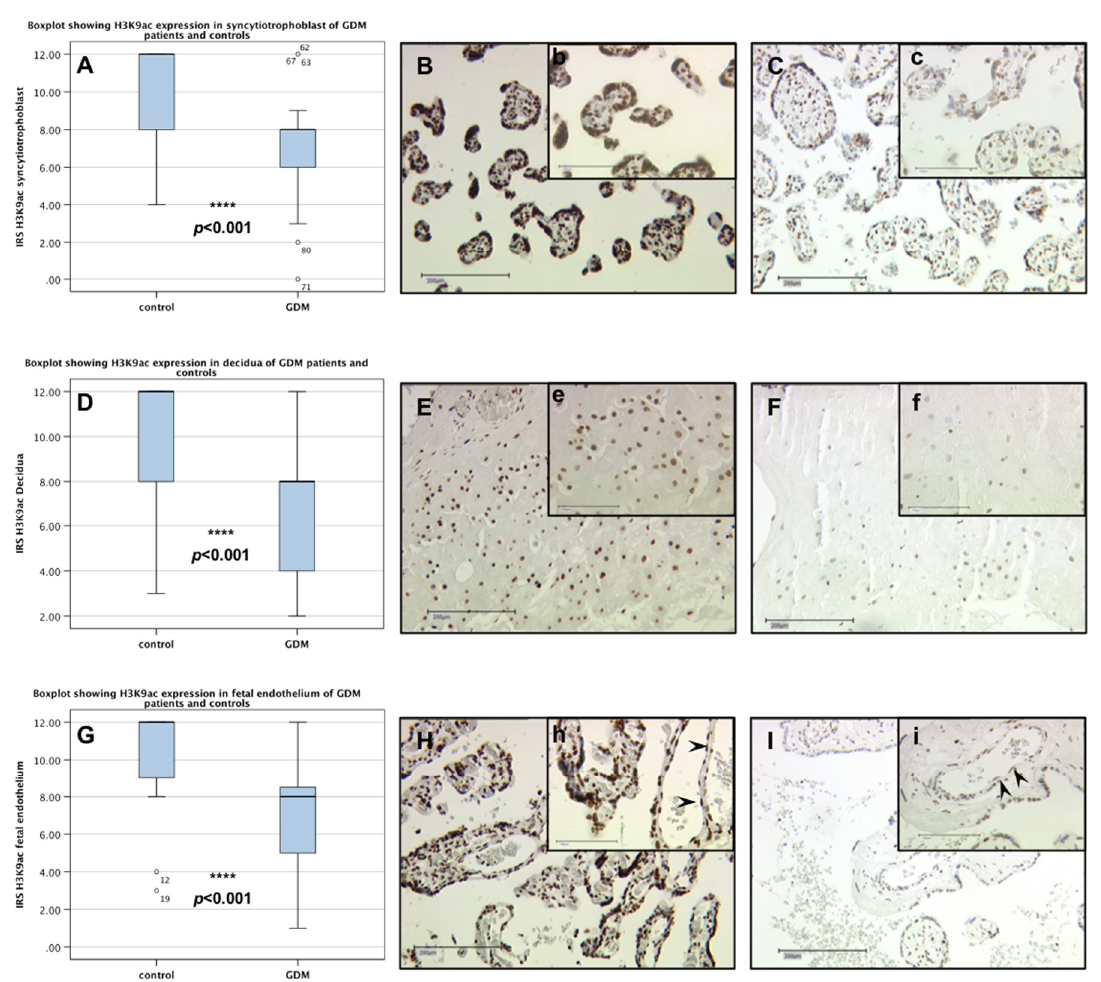
Figure 1. H3K9ac expression in syncytiotrophoblast, decidua and foetal endothelia cells of control and GDM placentas. Boxplots ( A , D , G ) showing the IRS for H3K9ac expression in syncytiotrophoblast (SCT), decidua and foetal endothelial to be highly significantly lower in GDM placentas ( p < 0.001). The range between the 25th and 75th percentiles is represented by the boxes with the horizontal line showing median. The bars indicate the 5th and 95th percentiles. Circles indicate values more than 1.5-times the boxes’ lengths. Pictures showing representative slides for immunohistochemical staining of H3K9ac in the SCT (control ( B , b ); GDM ( C , c )), decidua (control ( E , e ); GDM ( F , f )) and foetal endothelial cells (control ( H , h ); GDM ( I , i )) of according placentas. Arrowheads indicate foetal endothelial cells. Pictures were taken with a 100 × lens (capital letters) and 250 × lens (lower-case letters) respectively.